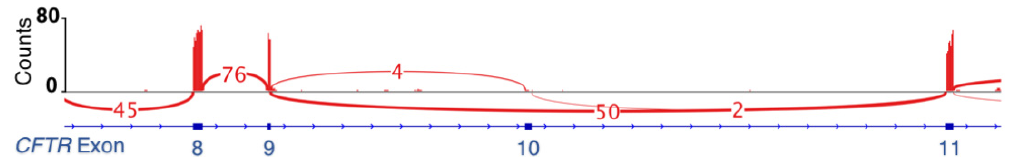
Figure 1. The sashimi plot for RNA sequencing reads aligned to CFTR exon 8 through exon 11. Read counts represent the number of reads aligned to each base in the exon. Bridges connecting exon pairs show the number of reads that span sequence in the two neighbouring exons (i.e., aligned to splice junctions). For the 56 reads aligned to the splice junctions spanning exons 9, 10 and 11, 50 (89.3%) skipped exon 10 and show direct connections between exons 9 and 11.